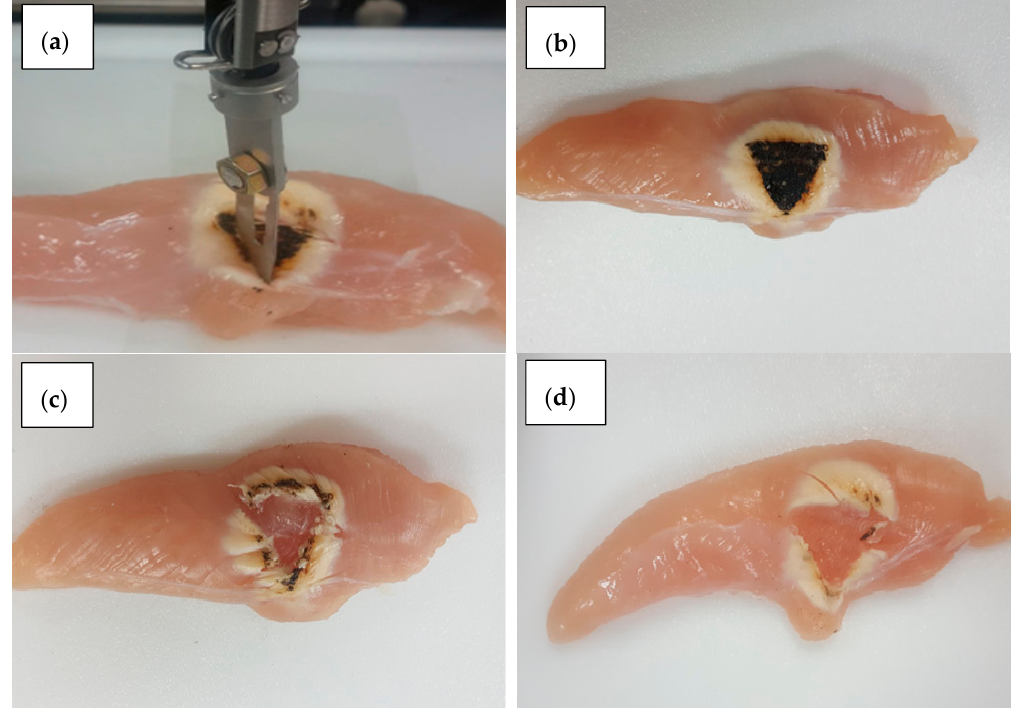
Figure 15. Surgical results; ( a ) cut operation; ( b ) tumor mark; ( c ) cut result with the haptic force only; ( d ) cut result with the haptic force and tactile sensation.